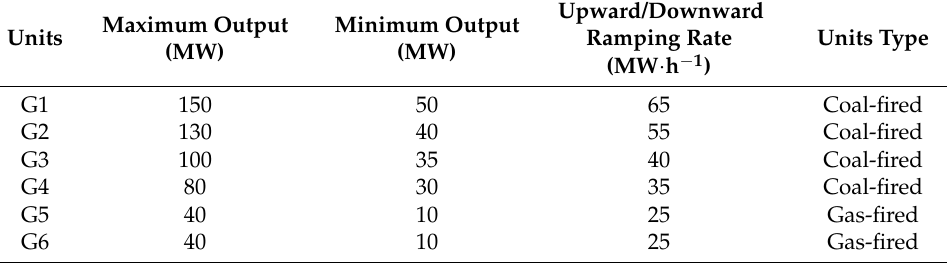
Table A1. Parameters of generating